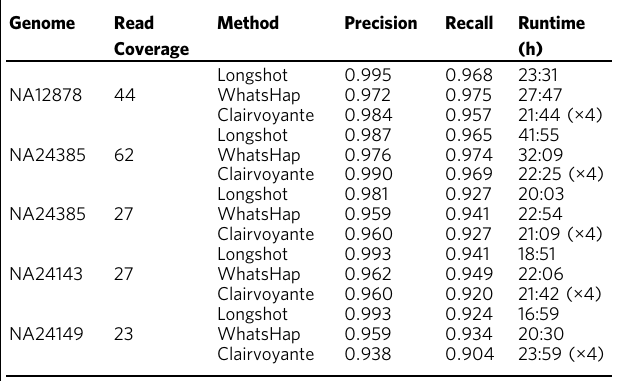
Table 1 Comparison of accuracy for variant calling methods on whole-genome SMS data